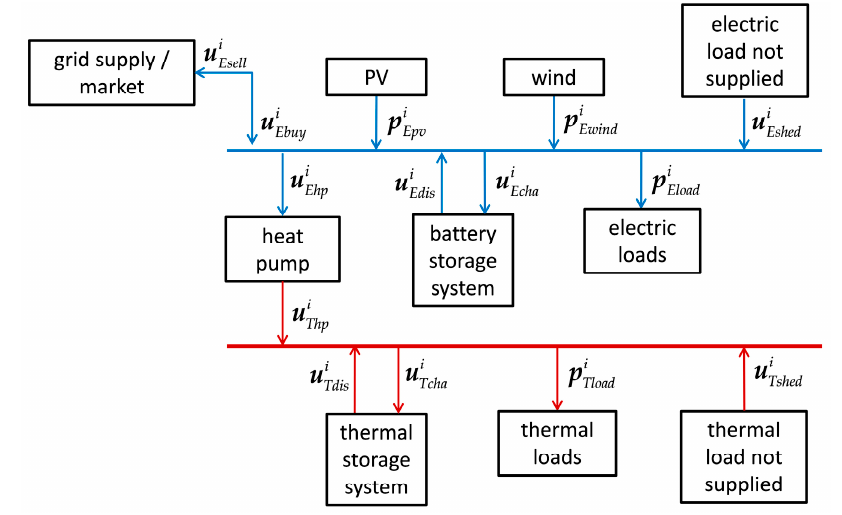
Figure 1. Schematic representation of the net zero multi energy system (NZMES) under study.